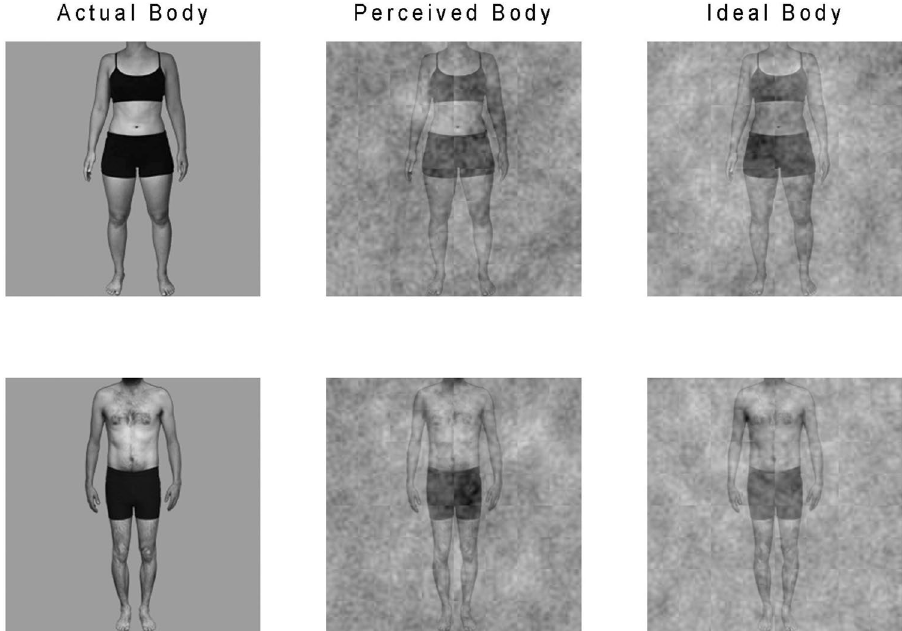
Figure 2. Examples of body images obtained in the image-construction phase. From left to right, a female and a male example of participants’ actual bodies (participant’s photograph), perceived bodies (mental representation of their actual body) and ideal bodies (mental representation of their ideal